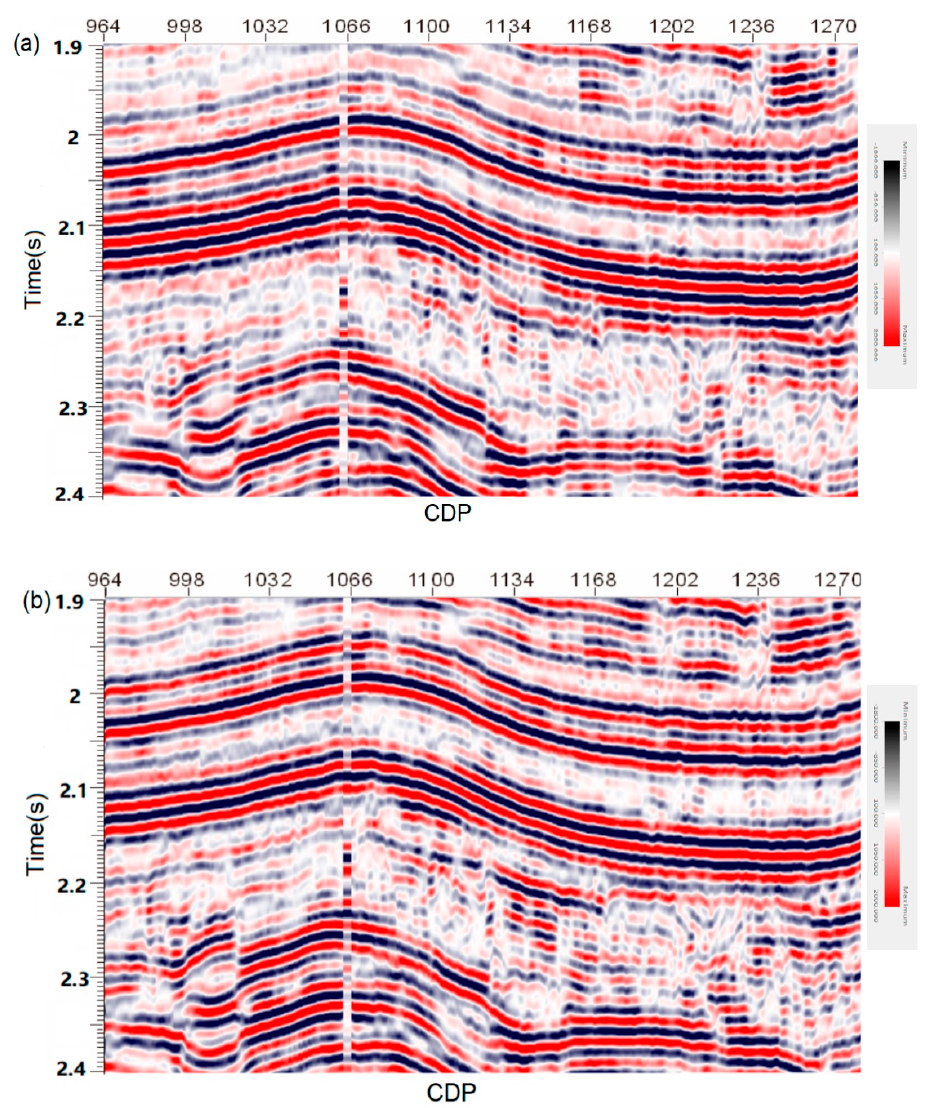
Figure 13. ( a ) Seismic section showing the deconvolution results after applying: ( a ) conventional ISTA; ( b ) the algorithm proposed in this study.